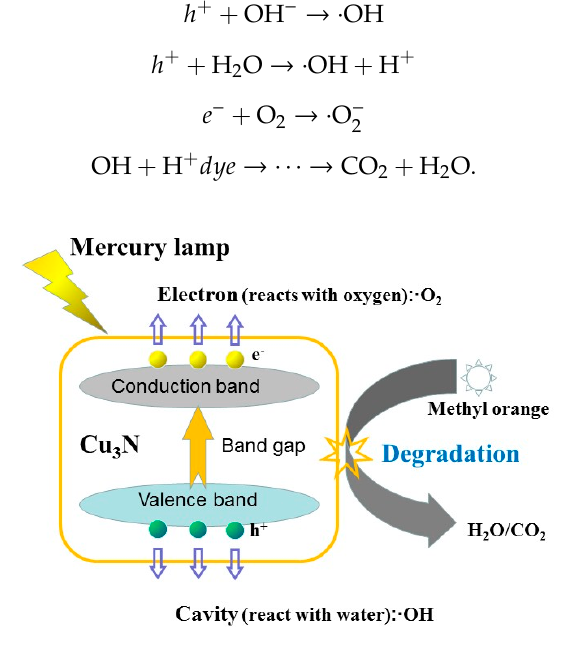
Figure 8. Scheme of photocatalytic degradation of methyl orange solution by the Cu 3 N films.